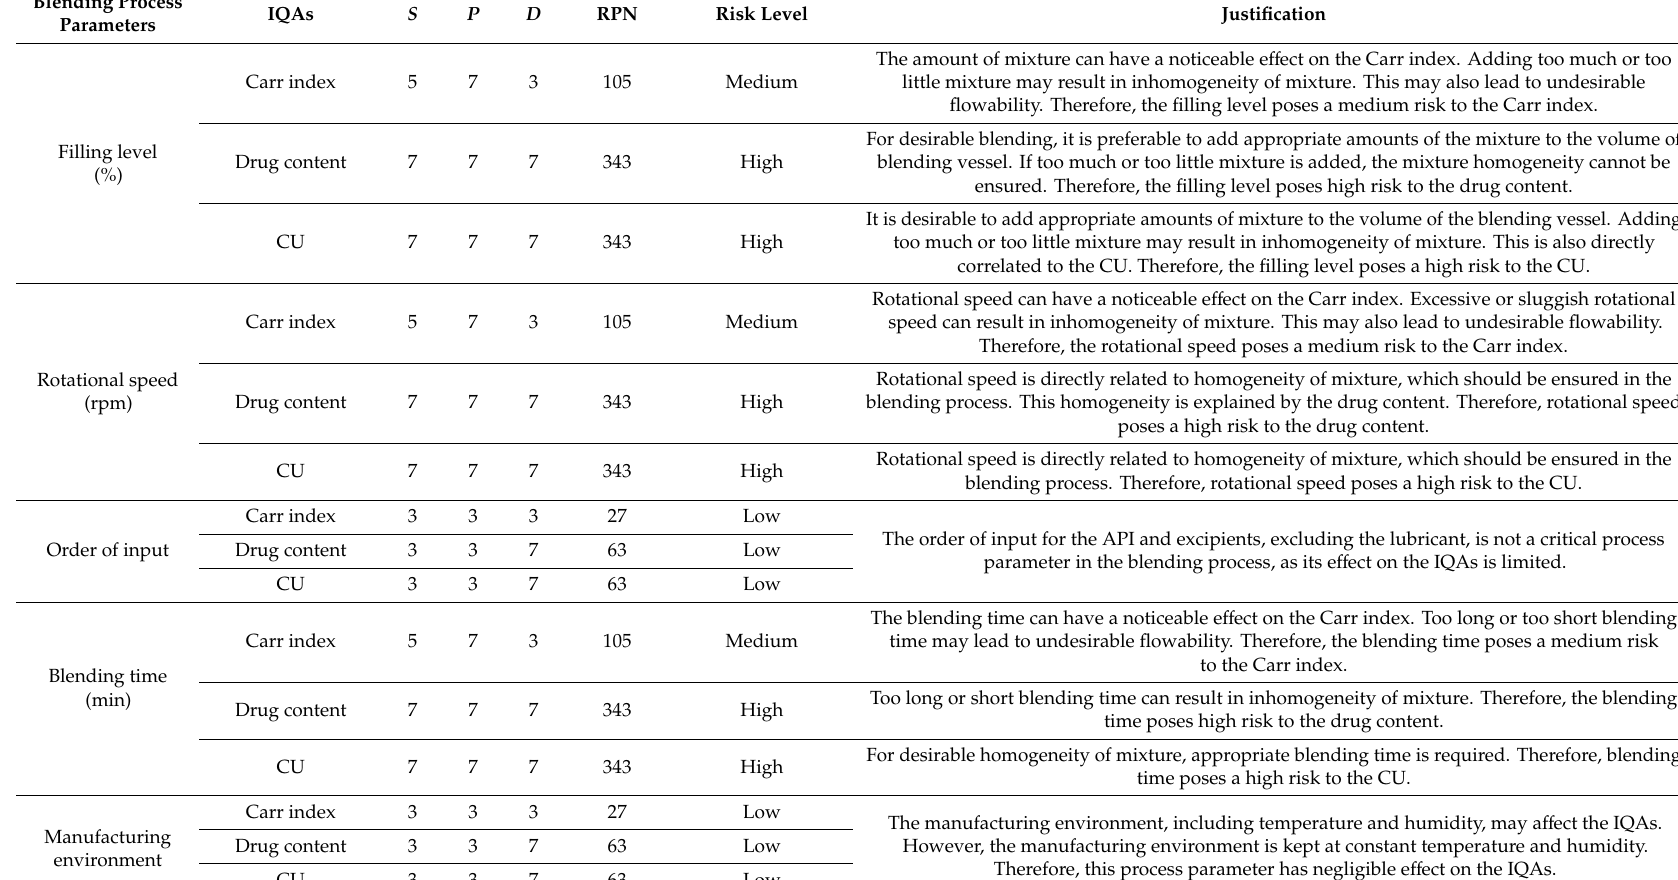
Table 2. Risk assessment of blending process parameters using risk priority number